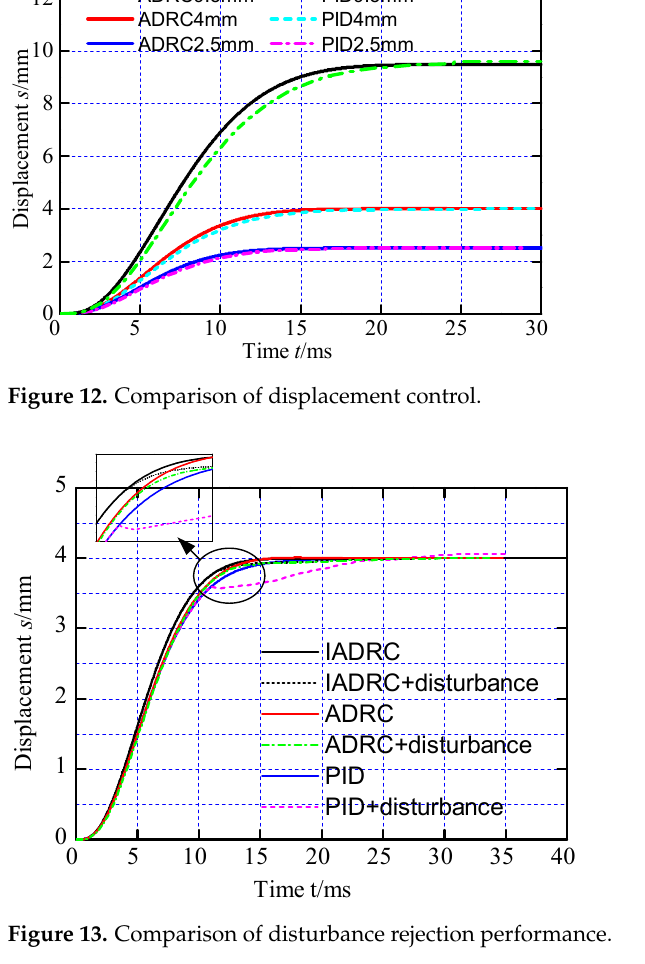
Figure 13. Comparison of disturbance rejection performance.